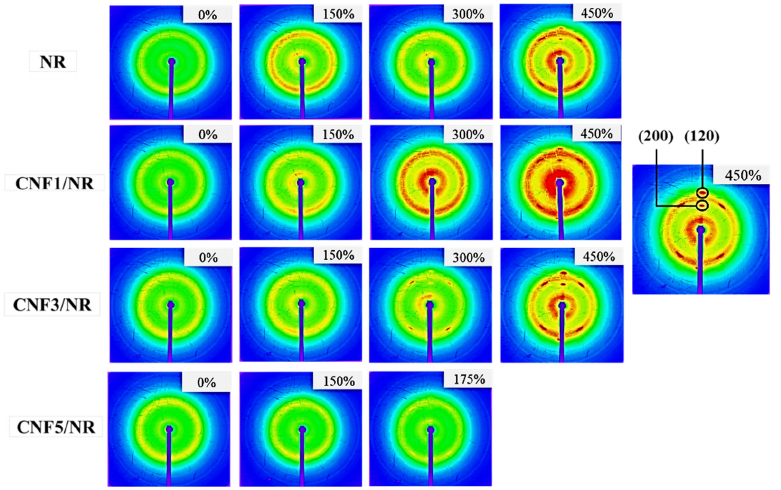
Figure 5. Typical two - dimensional WAXD images as a function of the applied strain for the NR and the CNF/NR nanocomposites. the CNF/NR nanocomposites.